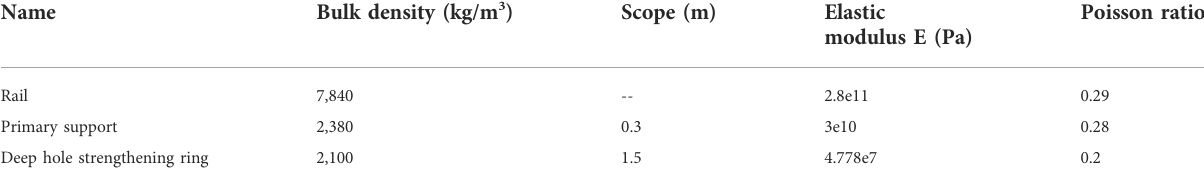
TABLE 5 Shaft and passage structure material parameters.